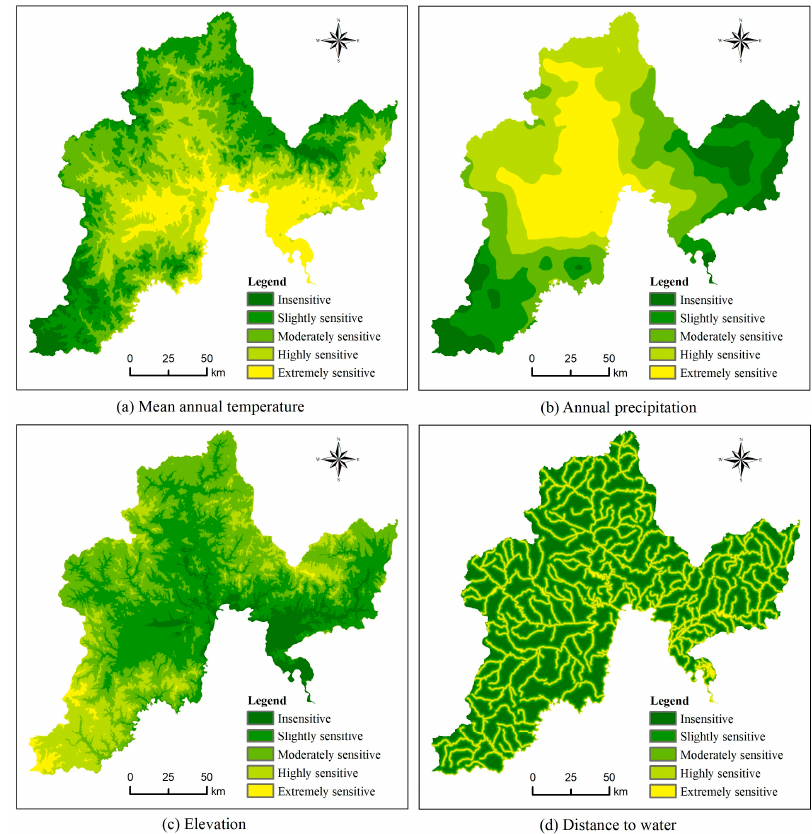
Figure 3. Distribution of ecological sensitivity of the natural environment.